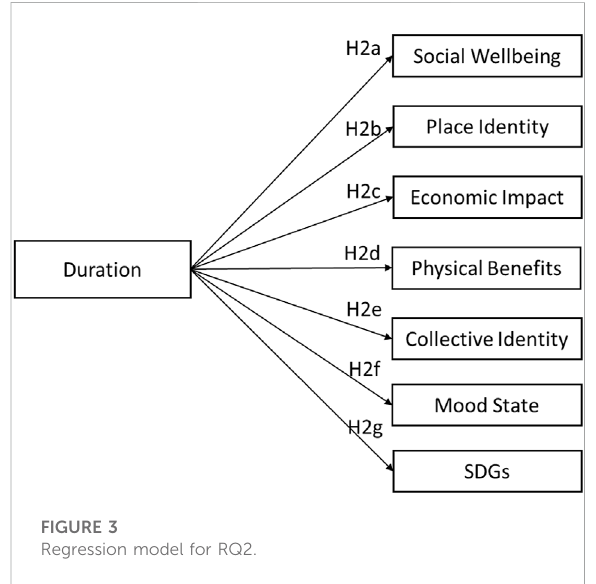
TABLE 3 Respondents ’ familiarity, Knowledge, and use of Green